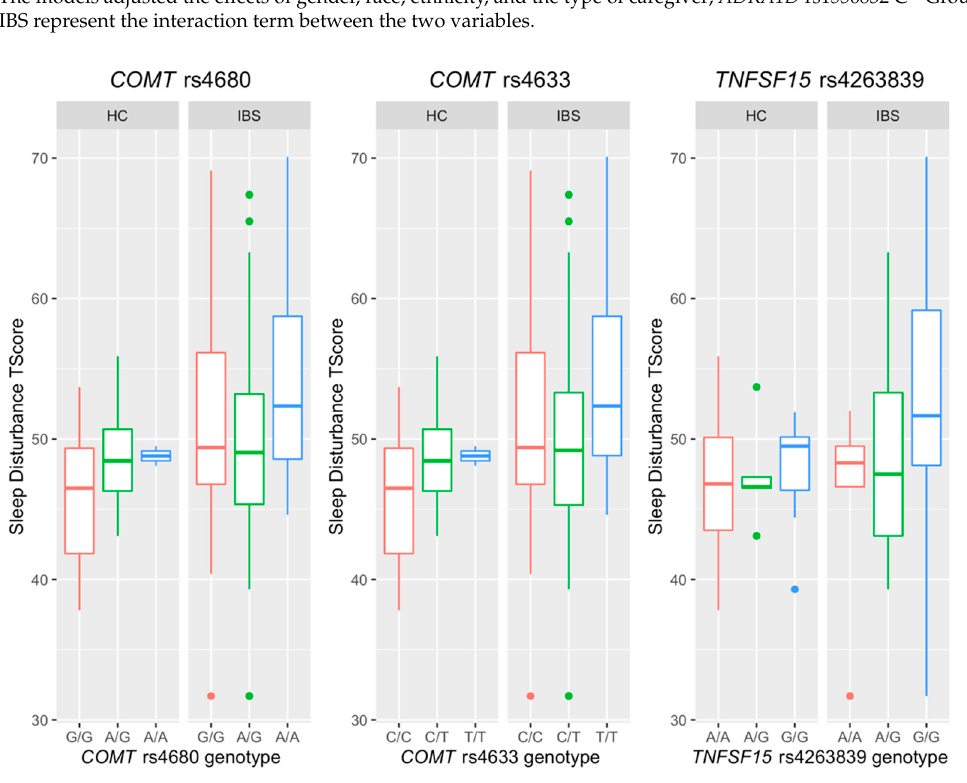
Figure 3. Boxplots for sleep disturbance T-Score in the genotypes of COMT rs4680, COMT rs4633, and TNFSF rs4263839.